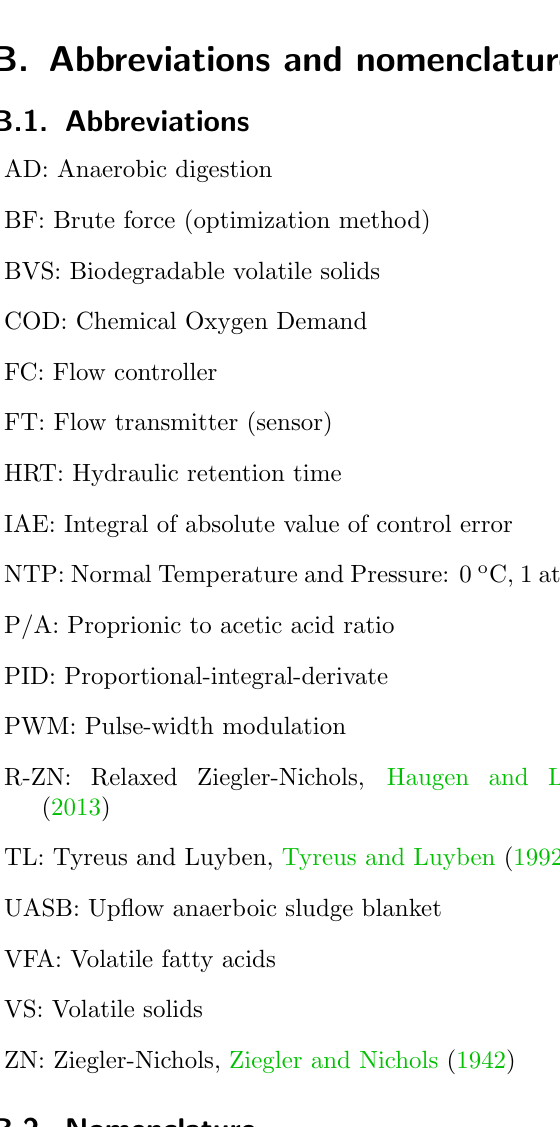
Figure 15: The composition of the transfer function H AD ( s ) , eq. m